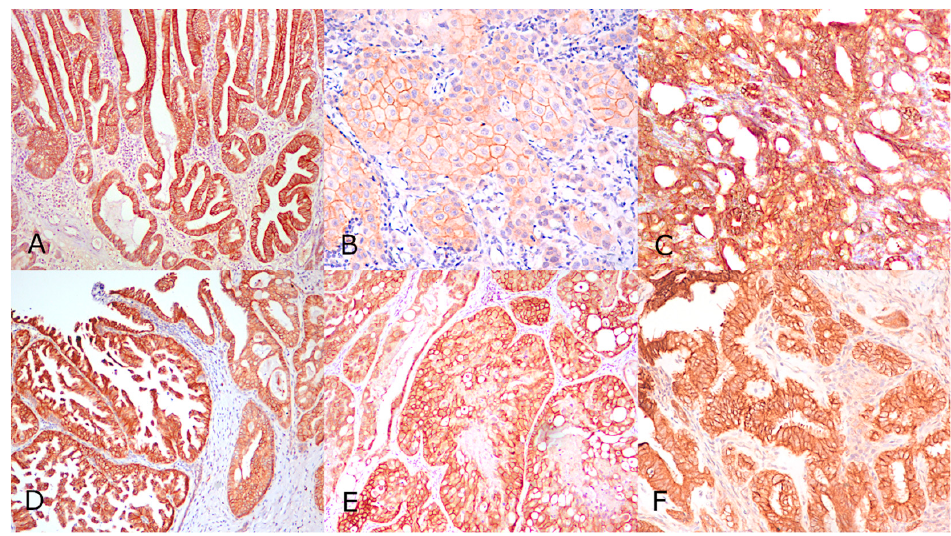
Figure 1. HER2 positivity in canine carcinomas, all cases displaying 3+ positivity characterized by complete and intense circumferential staining of the cell membrane. ( A ) Rectal carcinoma, ( B ) Oral Squamous cell carcinoma, ( C ) Gastric carcinoma; ( D ) Urothelial transitional cell carcinoma, ( E ) Prostatic carcinoma; ( F ) ovarian carcinoma. Avidin-biotin-peroxidase method, counterstained with Papanicolaou’s hematoxylin, 10×.